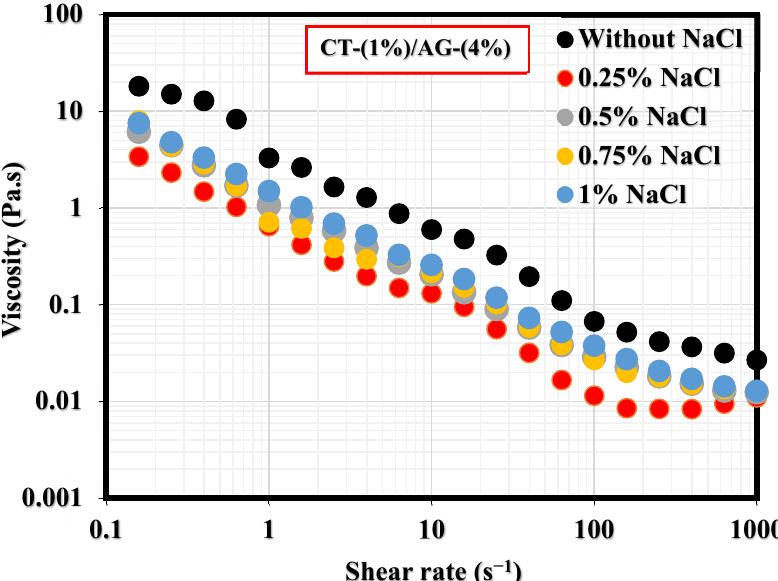
Figure 7. Viscosity behavior of 1%-CT/4%-AG emulsion at various NaCl concentrations.